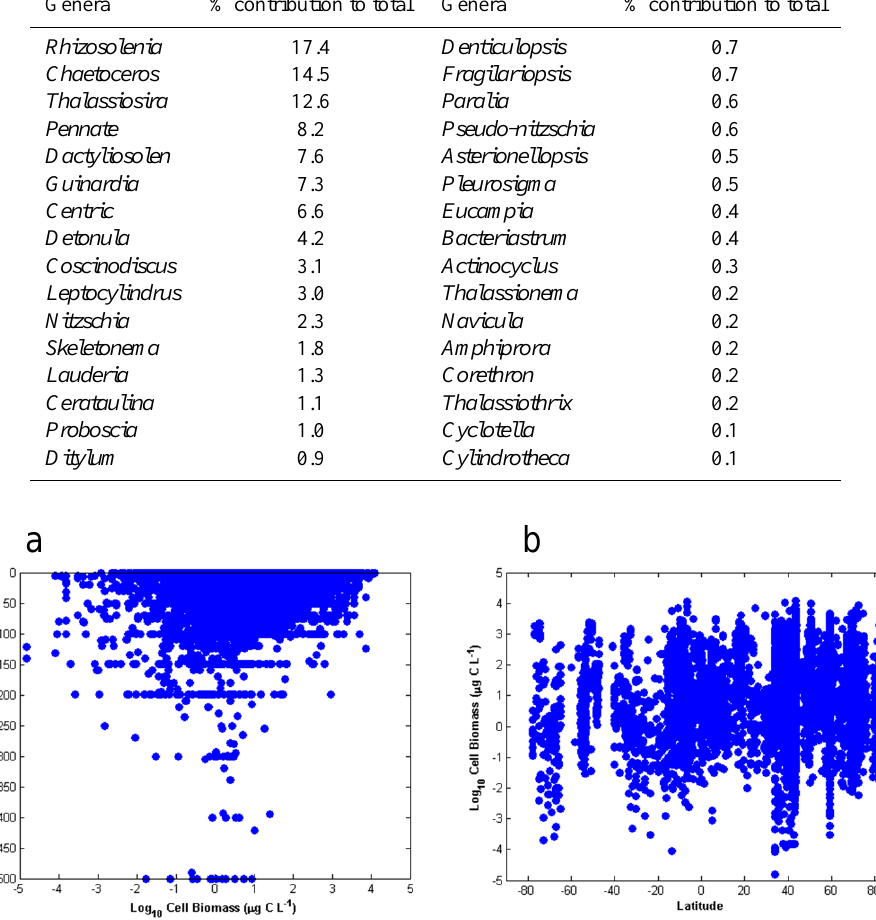
Figure 6. Distribution of log-normalized diatom biomass (log 10 µ gCl − 1 ) as a function of depth (a) and latitude (b) .